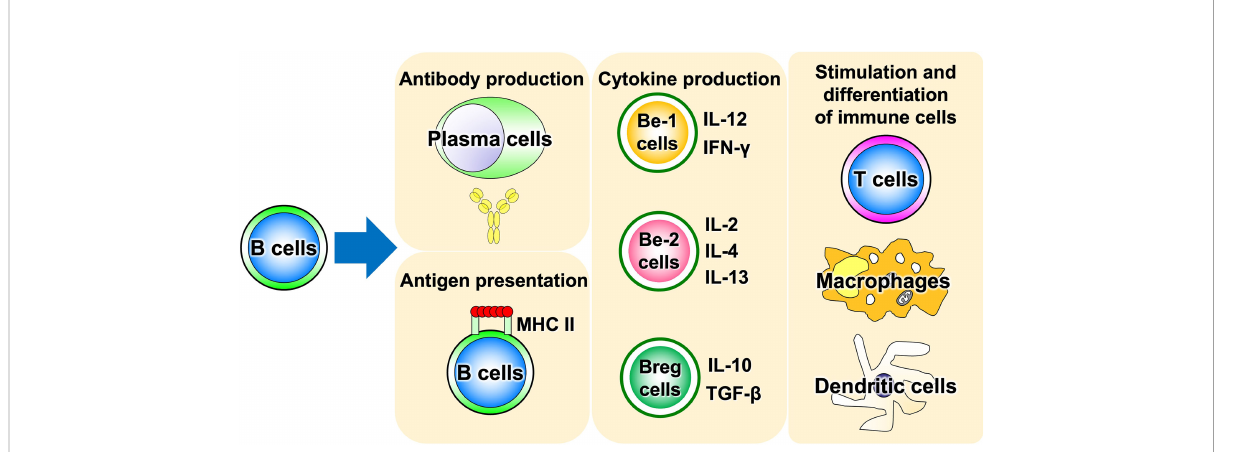
FIGURE 1 Various functions of B cells. B cells play a central role in the immune system, possessing a variety of functions such as antigen presentation, cytokine production, and induction of differentiation and activation of other immune cells, in addition to antibody production. Be cell, cytokine- producing effector B cell; Breg cell, regulatory B cell; MHC II, MHC class